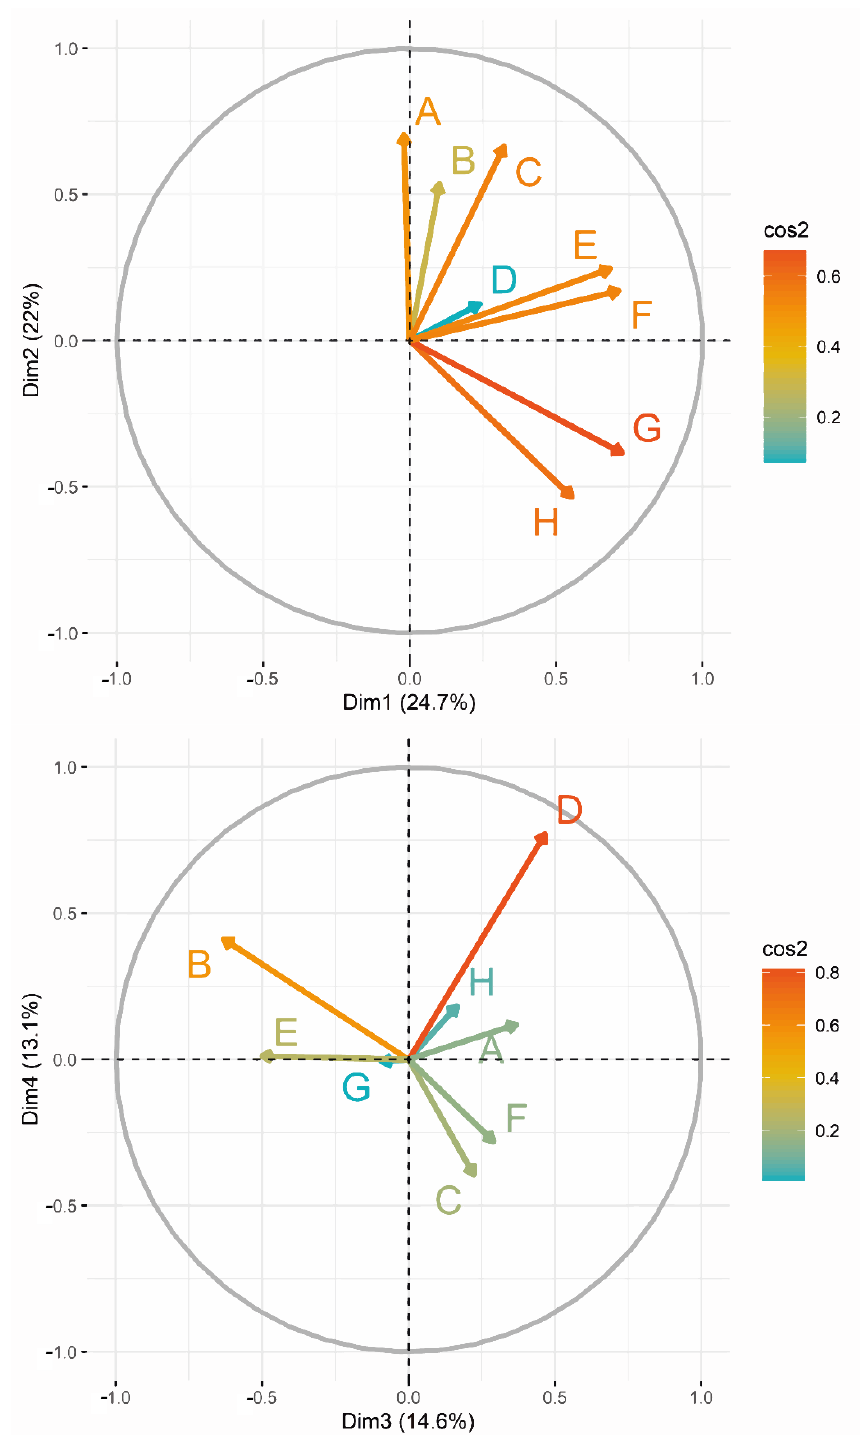
Figure 3. Variables factor maps on four dimensions (PSD – PCA). The factors are colored according to their quality of representation (A = rate of non-invasive samples; B = number of samples per individual per year; C = number of sex markers used; D = total number of samples gathered; E = number of STRs used; F = number of calculations done regarding the Population Structuring and Dynamics (PSD); G = number of types of samples used; H = time of study).